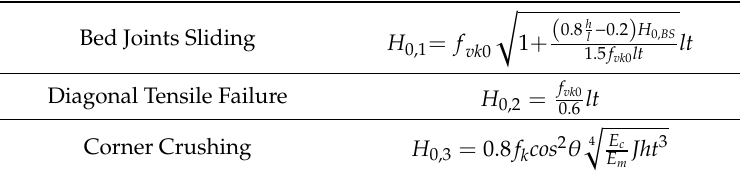
Table 2. Stafford-Smith Failure Modes adapted from [47,48]. Table 2. Sta ff ord-Smith Failure Modes adapted from